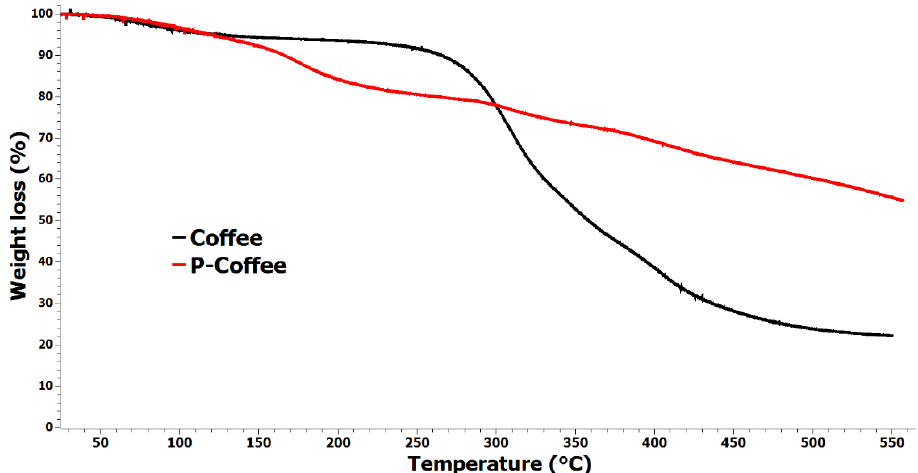
Figure 6. TGA thermograms of unmodified coffee biowaste (Coffee) and coffee biowaste modified with phosphorus (P-coffee) under nitrogen at 10 °C.min − 1 .